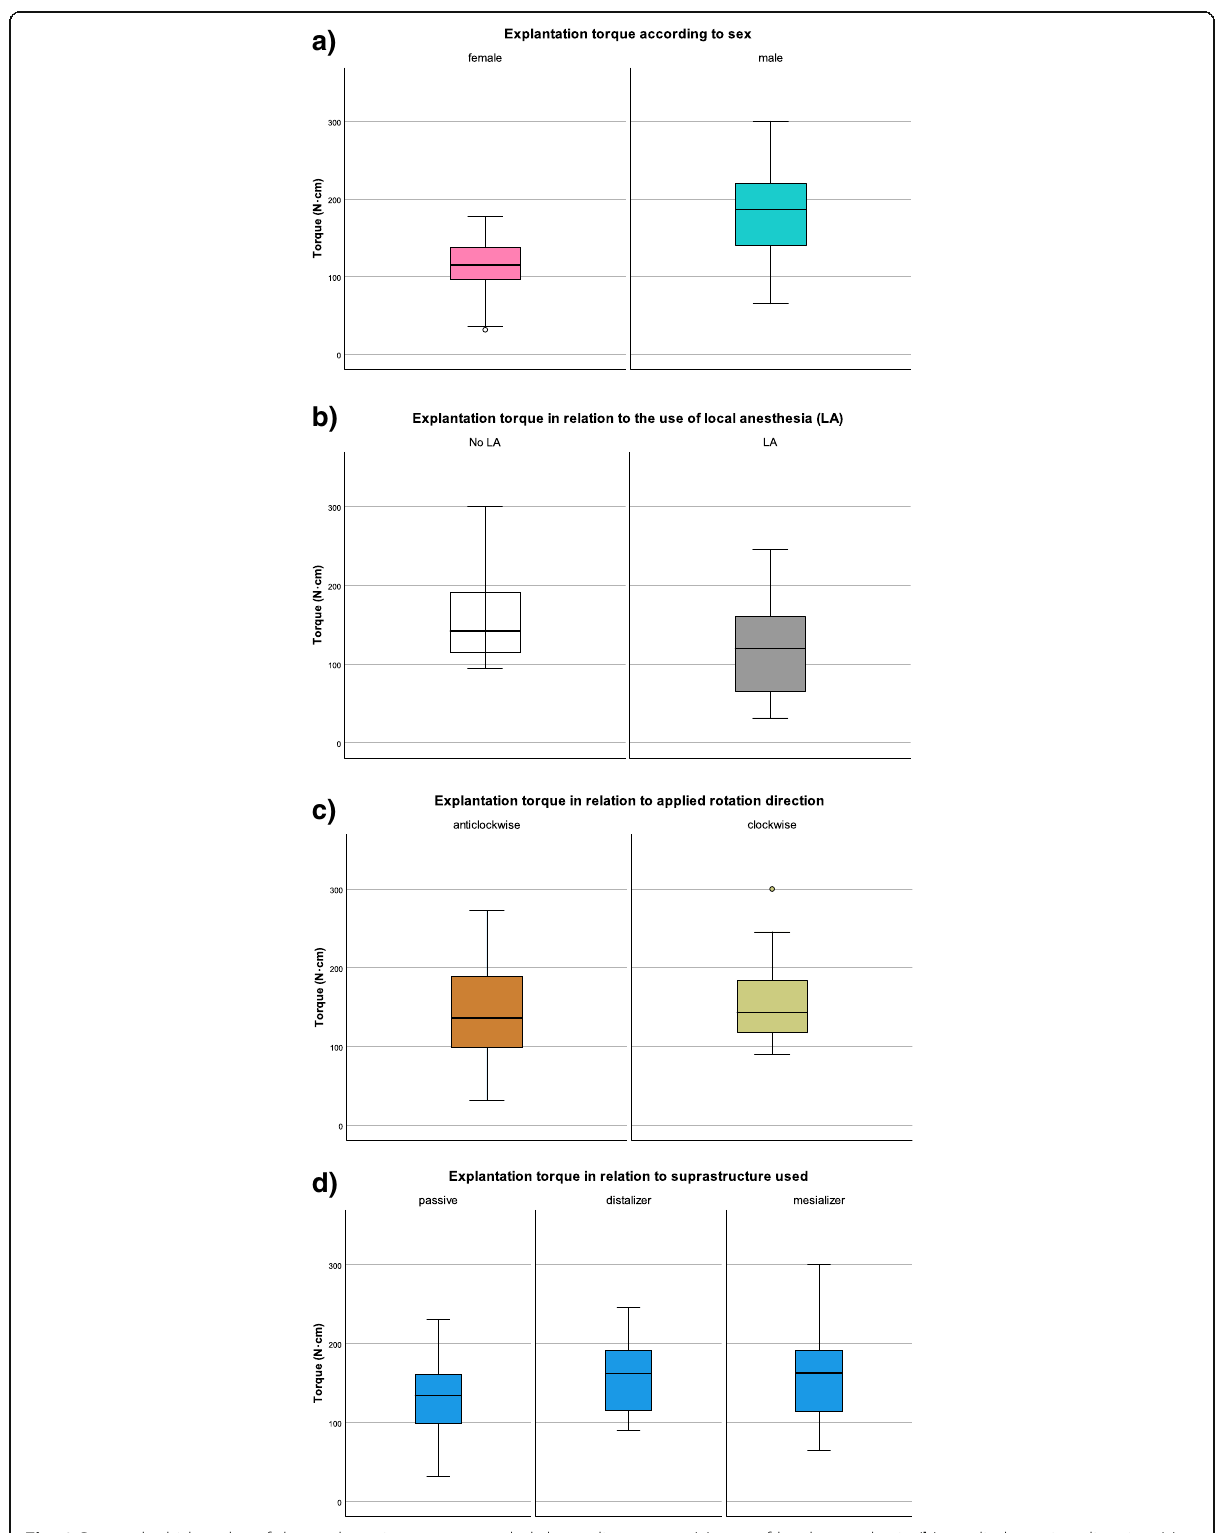
Fig. 2 Box and whisker plot of the explantation torque needed depending on sex ( a ), use of local anaesthesia ( b ), applied rotation direction ( c ), and the suprastructure previously used ( d